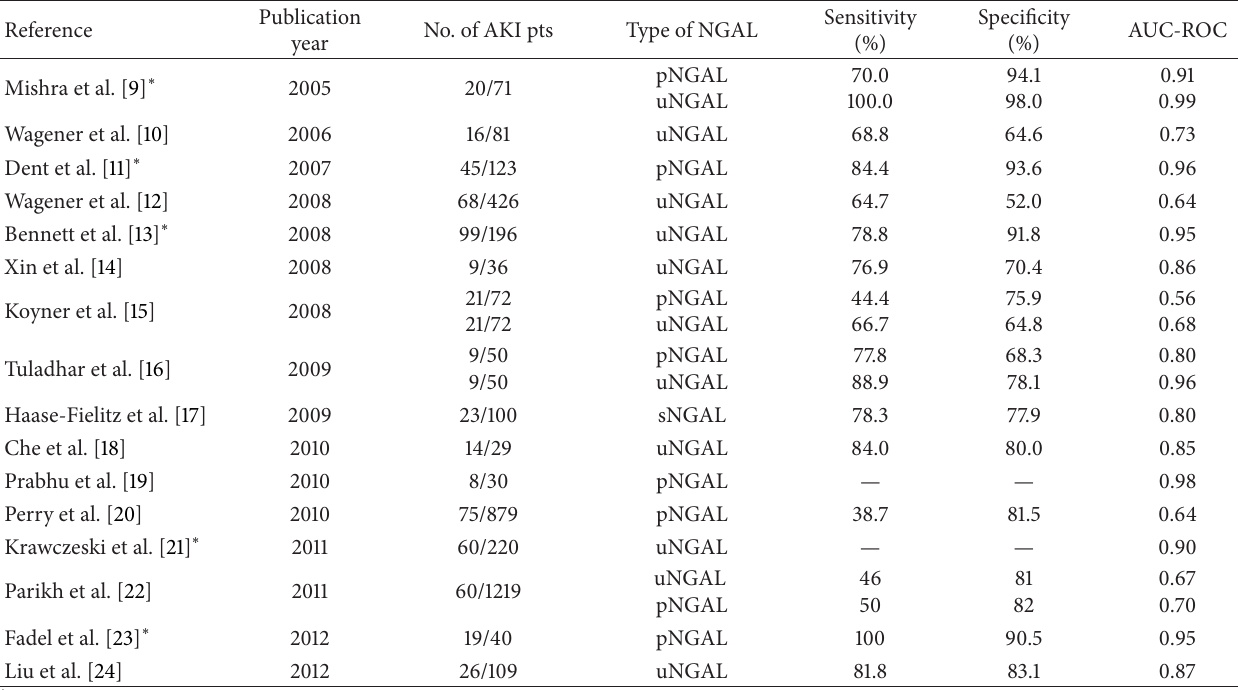
Table 1: NGAL for prediction of AKI after cardiac